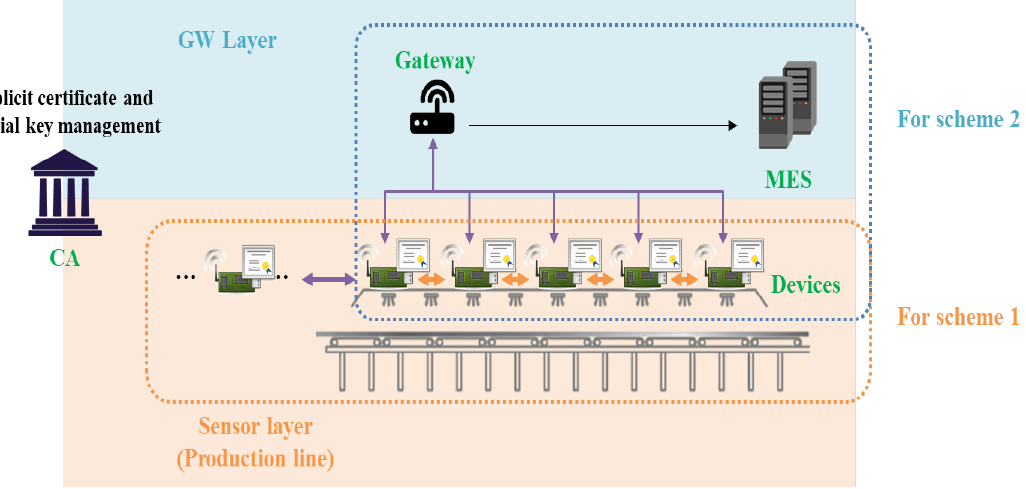
Figure 4. Proposed Internet of Things (IoT) smart factory service model for Schemes 1 and 2.